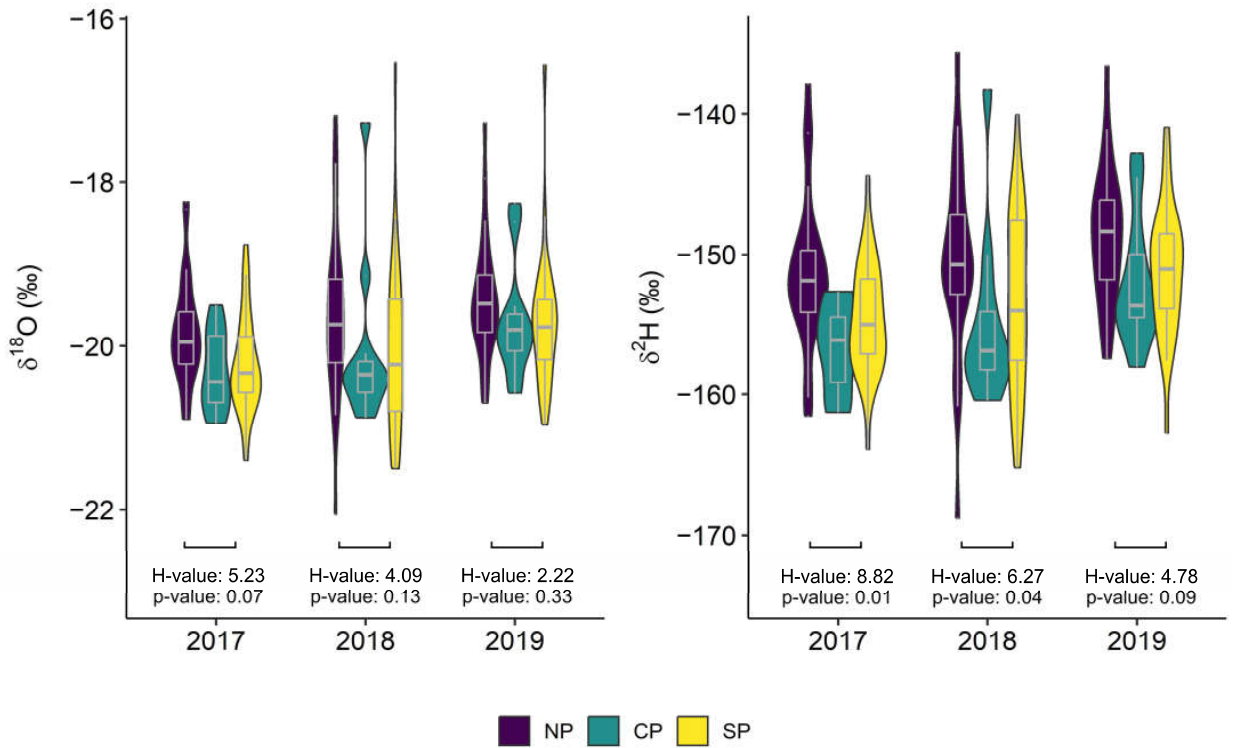
Figure 3. Temporal variability of the isotopic composition (δ 2 H and δ 18 O) of bulk snowpack over the basin parts (NP, CP, SP) with results of Kruskal–Wallis tests within sampling years. Violin and Tukey outlier box plots show the median value (horizontal line within the box), the 1st and 3rd quartile (ends of the box), minimum/maximum values (whiskers) and distribution.